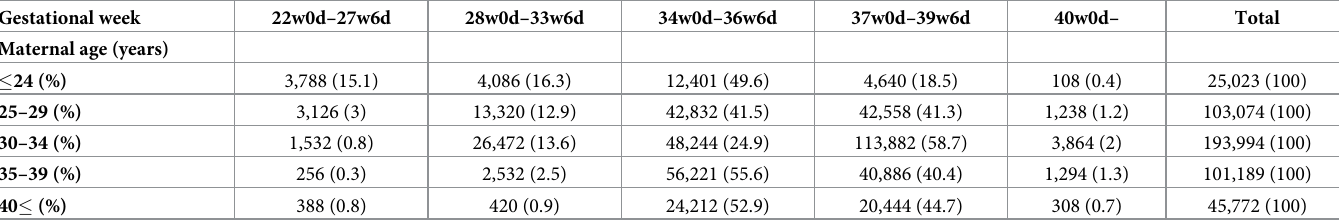
Table 7. Relationship between maternal age and gestational